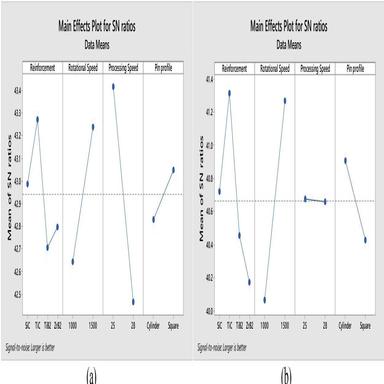
ain Effect plot for (a) Tensile Strength, (b) Yield Strength, (c) Percentage of Elongation, (d) interaction plot for Tensile Strength with process parameters.